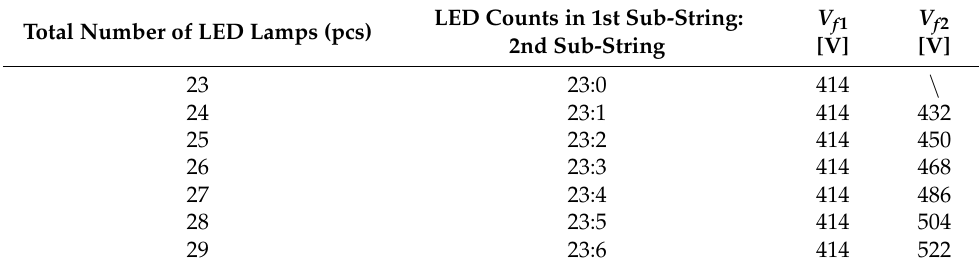
Table 2. The distribution of GaN LED lamps in sub-strings. Total Number of LED Lamps